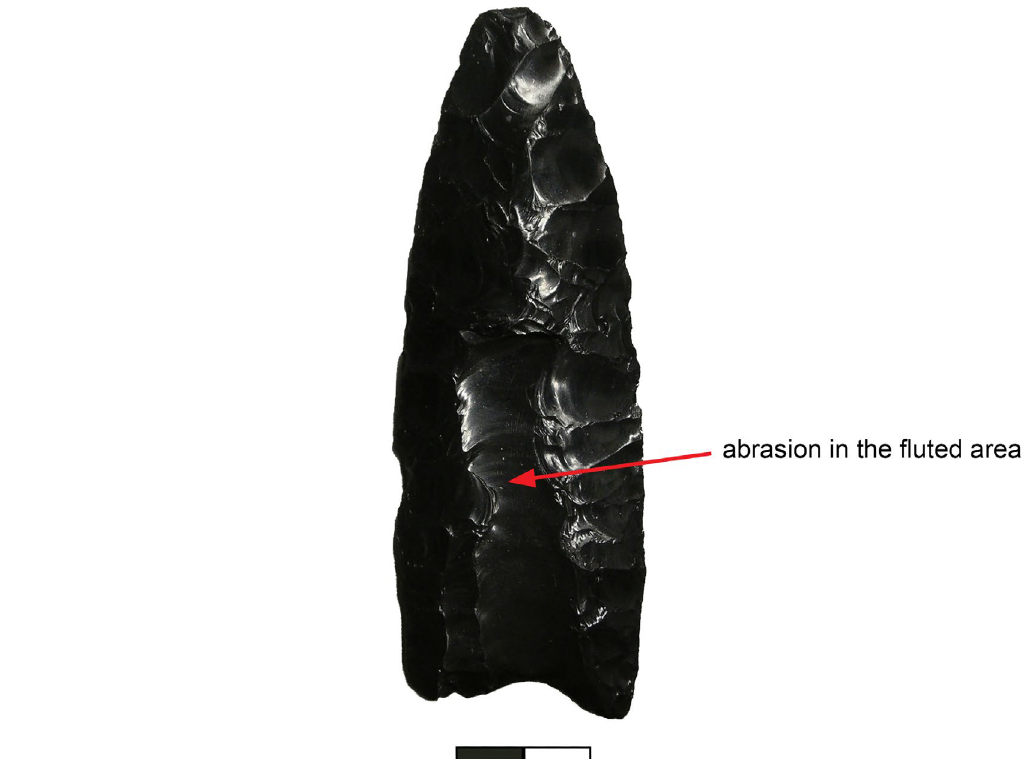
Figure 4. A Clovis fluted point from the Clovis type site at Blackwater Draw Locality No. 1, that displays the scratches in the fluted area which may facilitate hafting to a foreshaft (image after Slade 2016). The scale bar is 2cm wide (in 1 cm